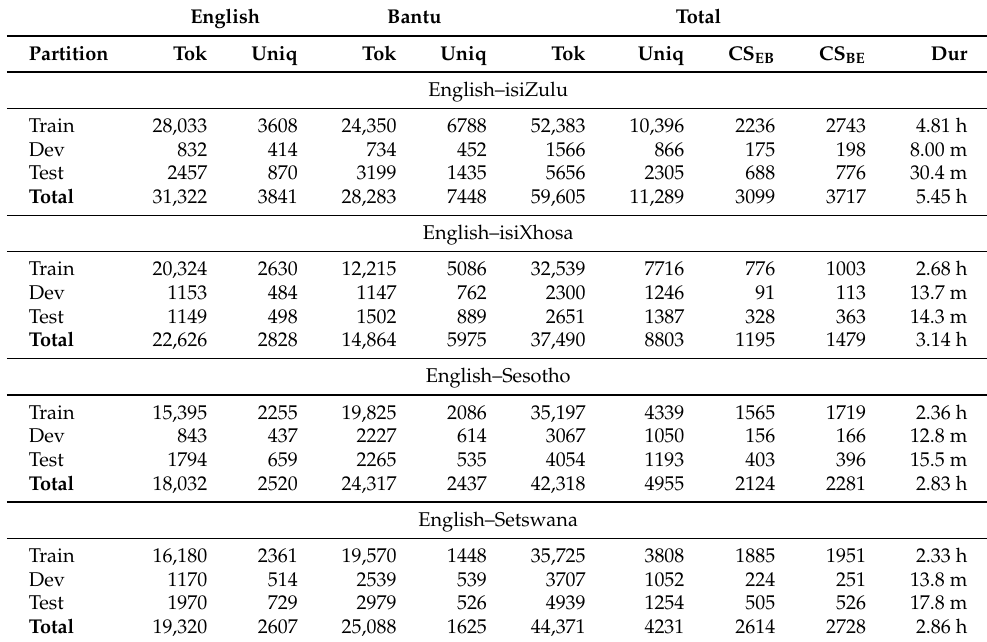
Table 1. The soap opera corpus, showing the four bilingual corpora (English–isiZulu, English– isiXhosa, English–Sesotho, and English–Setswana). For each corpus, the total number of word tokens (Tok), word types (Uniq), and code switches (CS) is presented. We denote the number of code- switches from English to a Bantu language as CS EB , while CS BE indicates the number of switches from Bantu to English. The final column (Dur) presents the duration of each corpus in minutes (m) or hours (h). Adapted from van der Westhuizen and Niesler (2018).